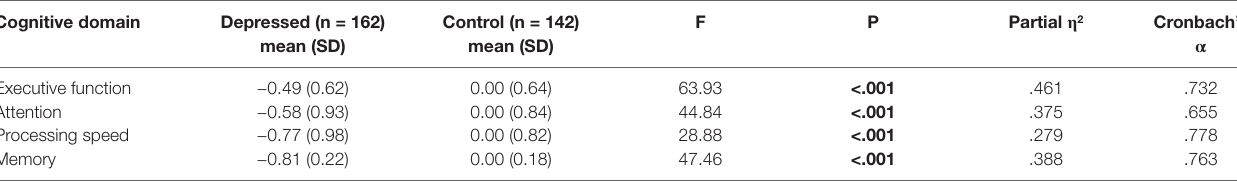
TaBlE 2 | Comparisons between MDD and HC groups in the four cognitive domains (Z-score) (MANCOVA test). Cognitive domain